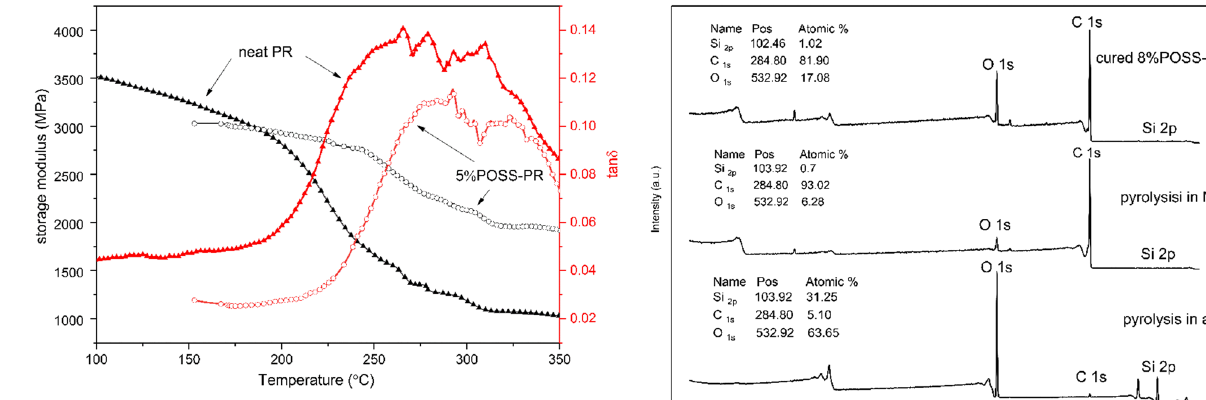
Figure 10: DMA result of cured PR, 5% POSS - PR.